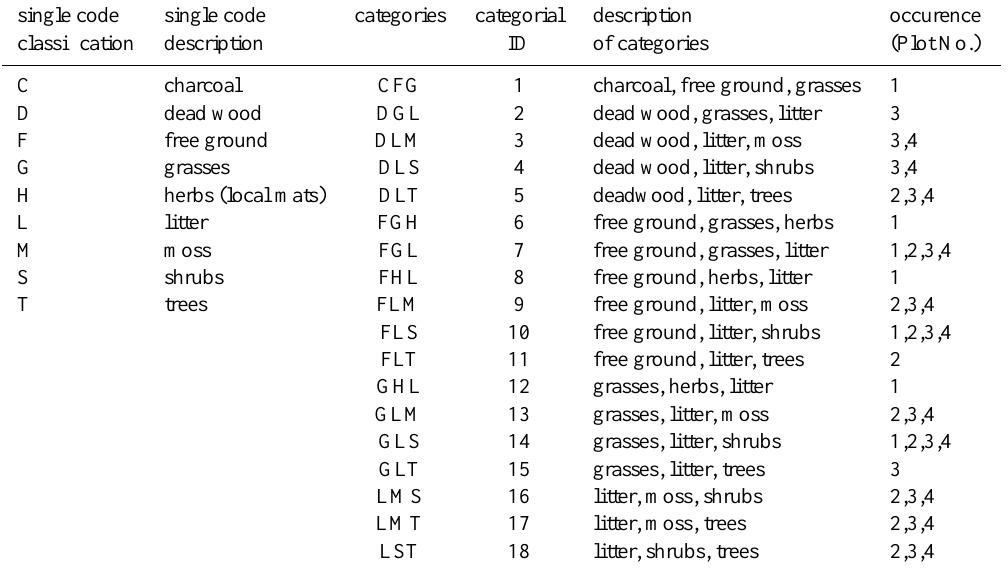
Table 1. Description for the different codes of ground cover and the combination of the 3 most abundant ground cover types for each subplot and the finally used ground cover categories that were finally chosen. Several categories can be found in each plot, others are specific for a single plot, e.g. CFG in plot